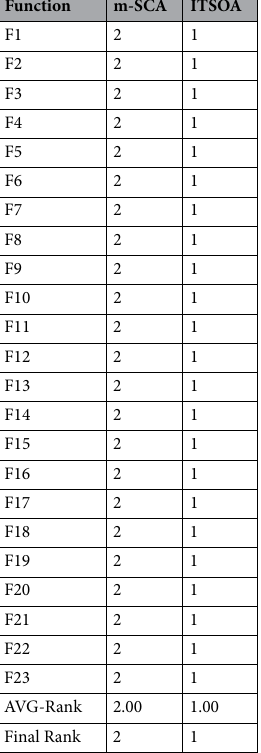
Table 3. Friedman ranks of ITSOA and m-SCA for all test functions.